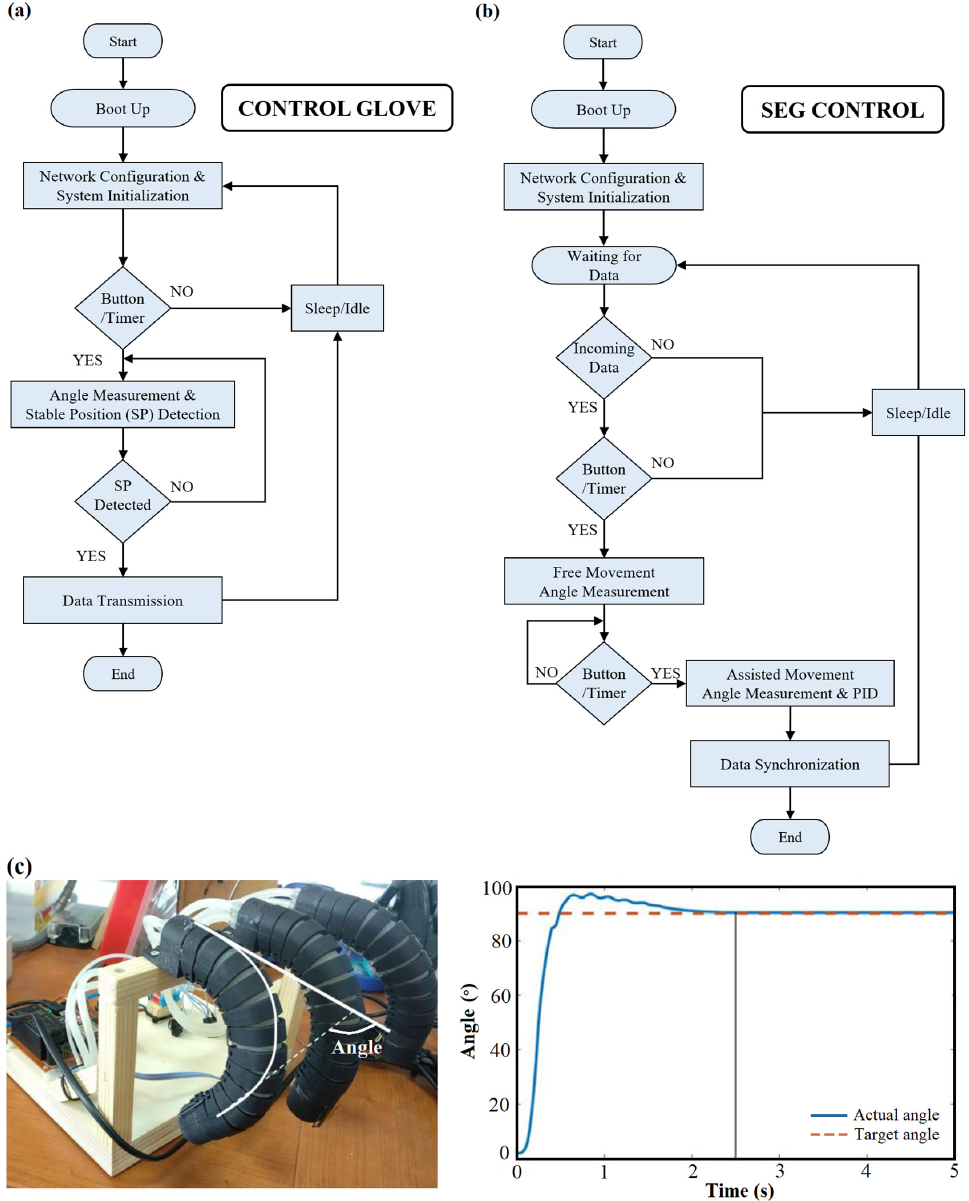
Figure 6. ( a ) Flowchart of the control glove; ( b ) Flowchart of the SEG control software; ( c ) Experimental set-up of the control and functionality testing coupled with the response diagram of the control configuration.